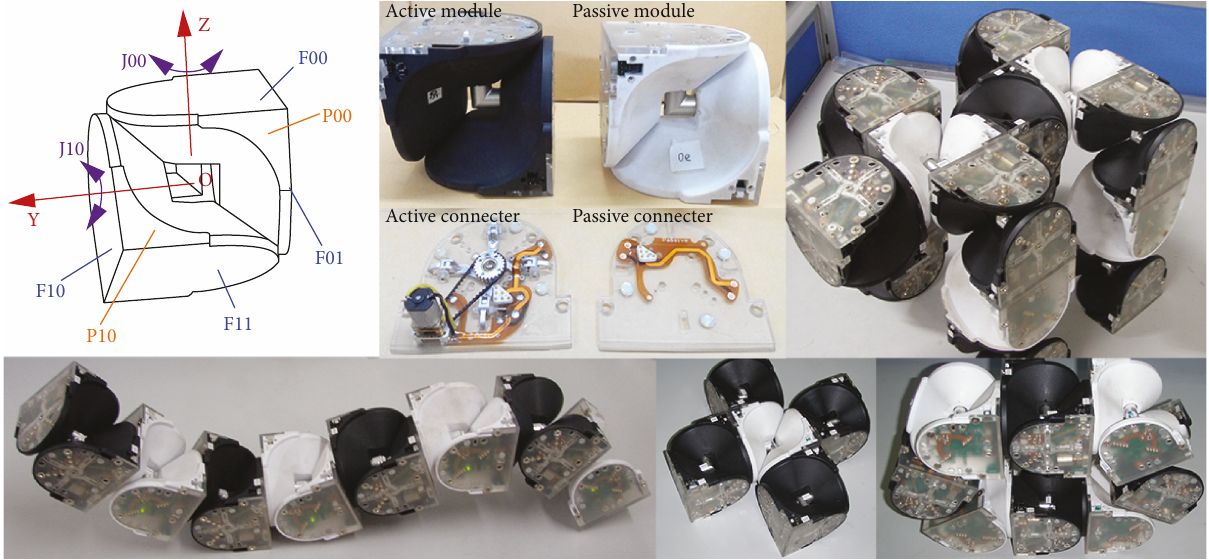
Figure 2: UBot modules and some typical robotic con fi gurations.